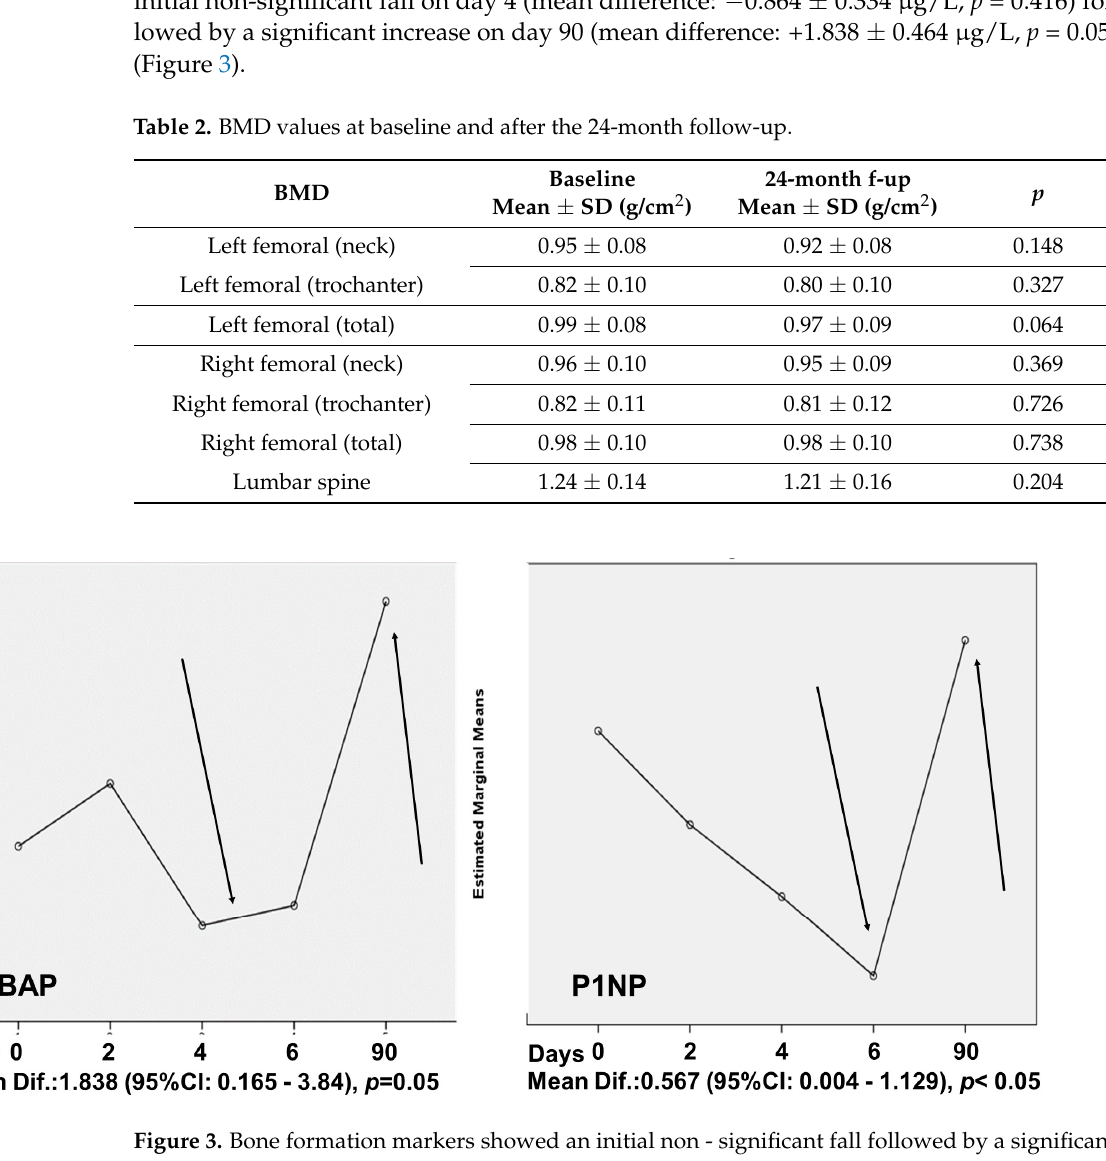
Figure 4. Percentage changes from baseline to 24 months in left femoral trochanter BMD were pos- itively correlated with the percentage changes of Periostin and negatively with CTx levels.